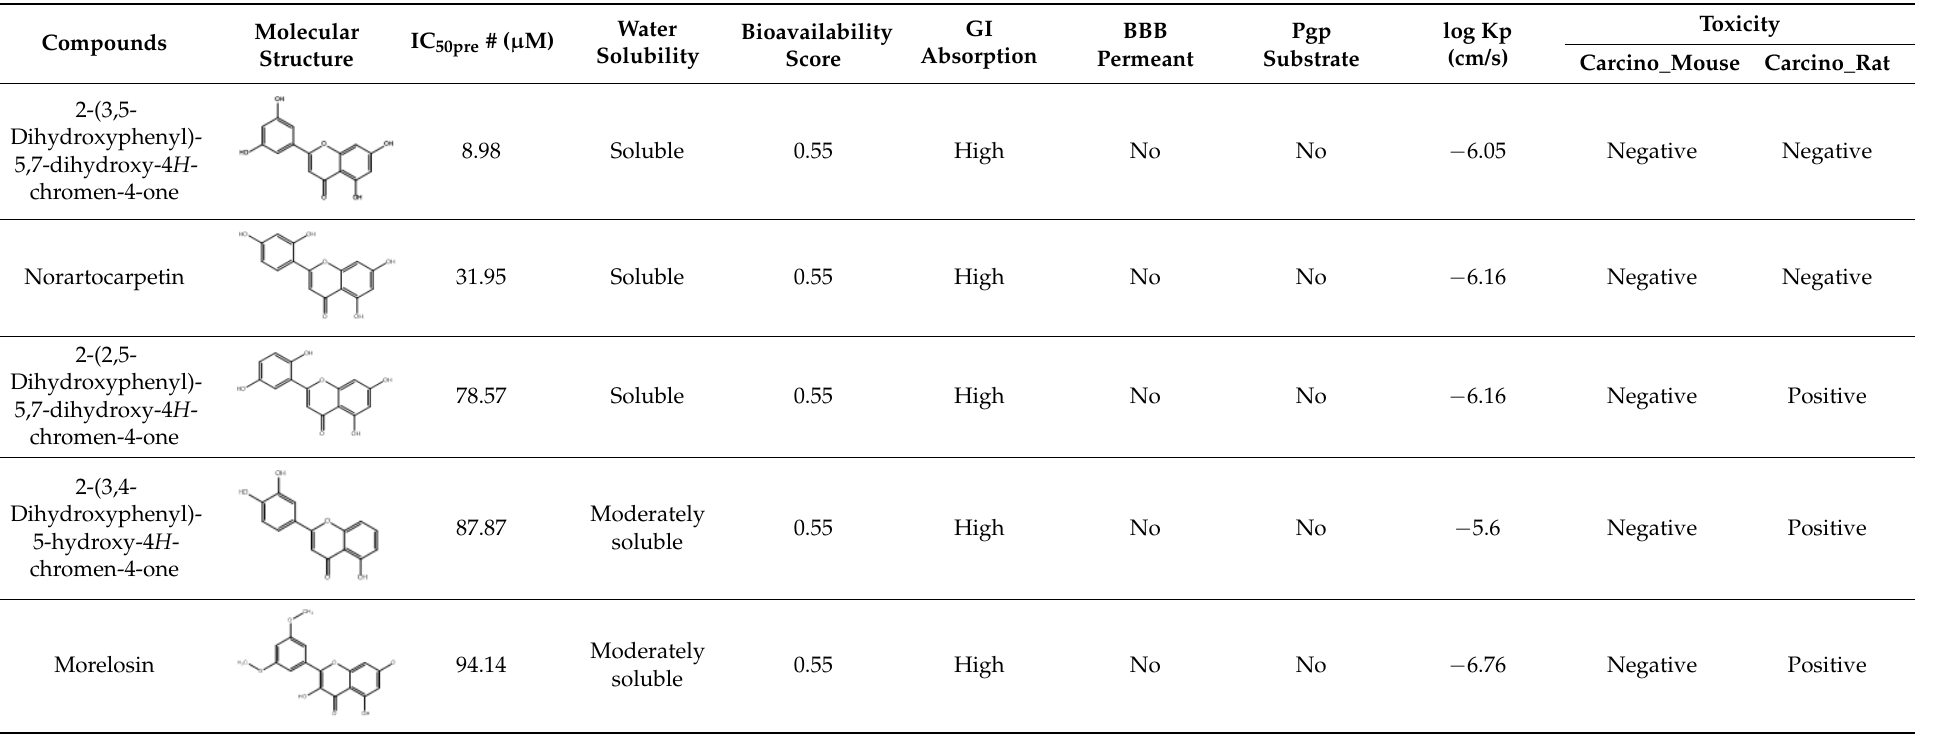
Table 3. The 2D-MLR-QSAR prediction and ADMET analysis of potential natural α -glucosidase inhibitors.